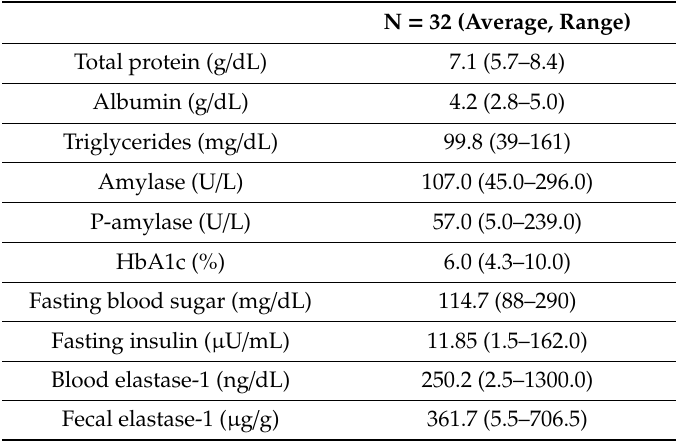
Table 2. Laboratory